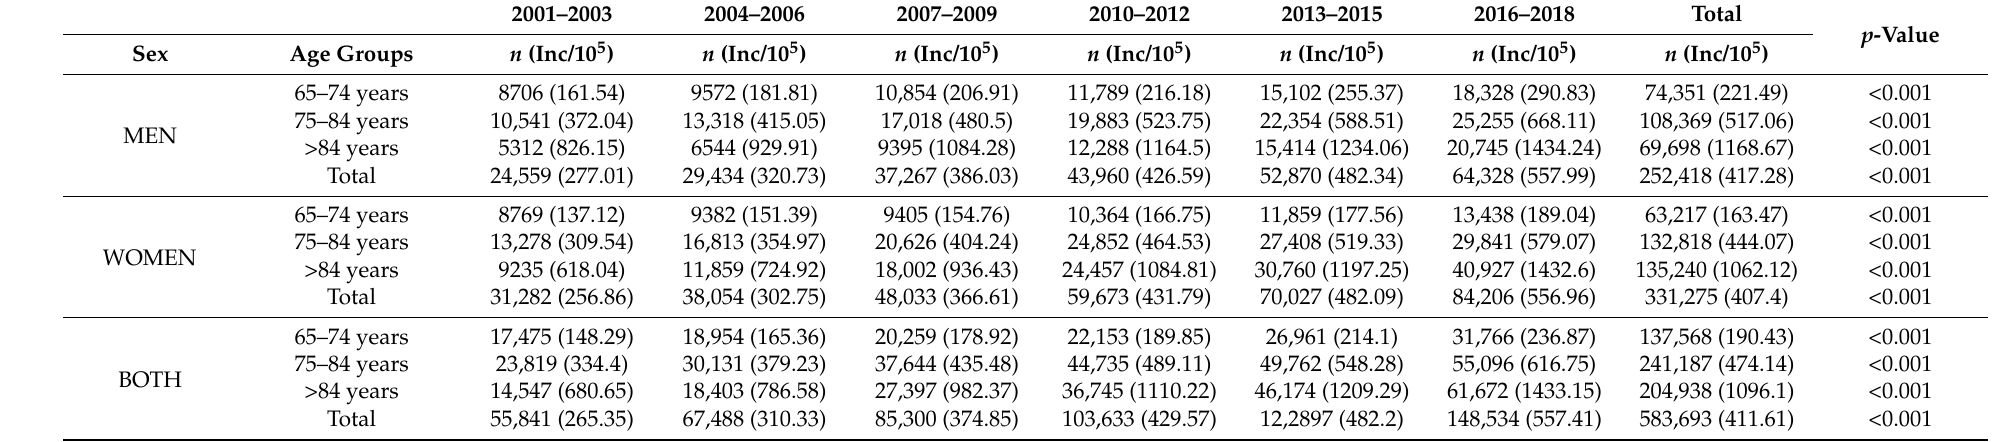
Table 1. Hospital admissions among the elderly with a principal diagnosis of urinary tract infection per 100,000 inhabitants according to age groups and sex in Spain from 2001 to